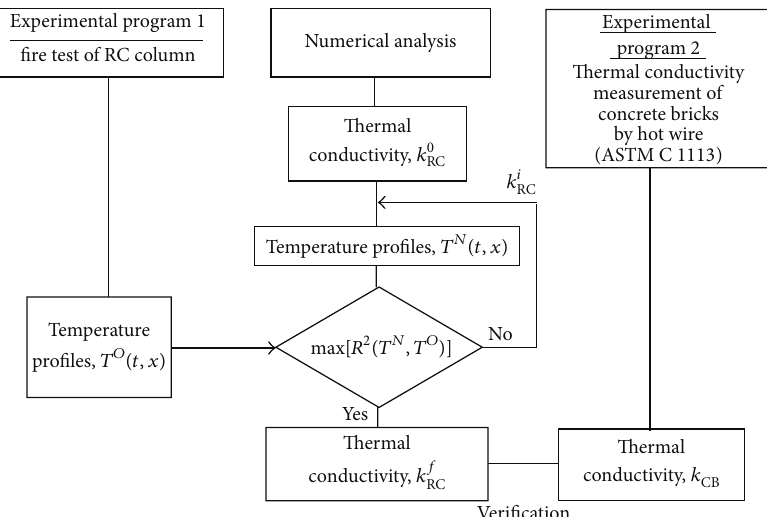
Figure 1: Layout of the proposed research program to extract thermal conductivity from unsteady-state test measurements and verify the measurements using standard test